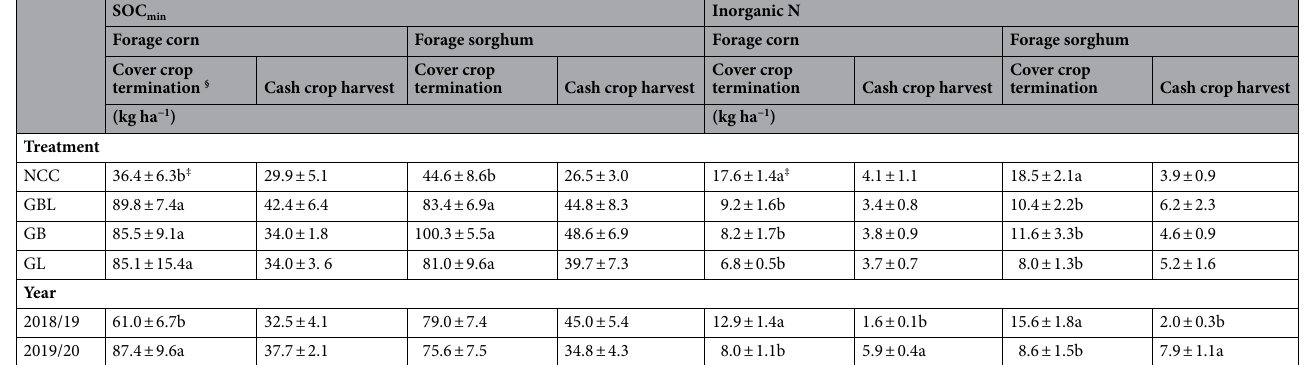
Table 2. Average soil organic C mineralization (SOC min ) from incubation study and inorganic N (0–0.10 m) under diverse cover crop treatments. NCC no cover crops control, GBL grasses, brassicas, and legumes mixture, GB grasses and brassicas mixture, GL grasses and legumes mixture. ‡ Mean values (± standard error) followed by different lowercase letters in a column indicate significant differences among cover crop treatments or between years ( p ≤ 0.05, LSD test). § Cover crop termination represented soil analysis results sampled on April 18, 2019, and May 15, 2020, whereas cash crop harvest represented soil analysis results sampled on September 26, 2019, and September 19,